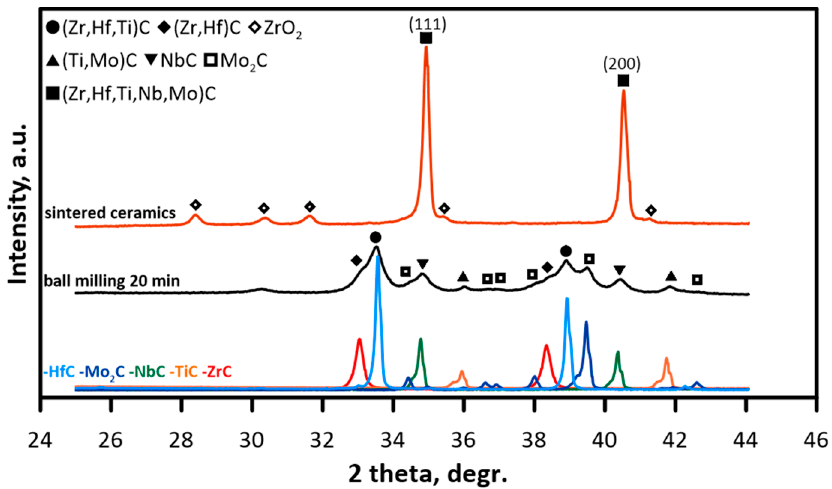
Figure 1. X-ray di ff ractograms of the initial powder mixture, powder mixture after 20 min of Figure 1. X-ray diffractograms of the initial powder mixture, powder mixture after 20 min of mechanical treatment and (Hf,Zr,Ti,Nb,Mo)C sintered ceramic. mechanical treatment and (Hf,Zr,Ti,Nb,Mo)C sintered